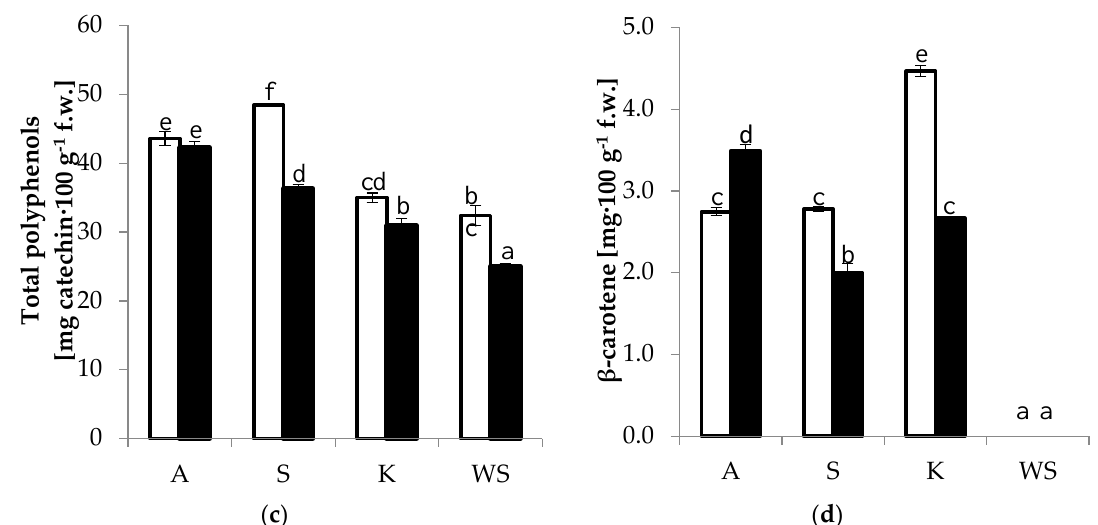
Figure 4. Antioxidant properties of carrot juices. ( a ) Antiradical activity relative to the ABTS; ( b ) Antiradical activity relative to the DPPH; ( c ) Total polyphenols; ( d ) β-carotene. White bars, CJ and black bars, BCJ. Various types: A, Askona F1; S, Samba F1; K, Kazan F1; WS, White Satin. Mean ± SE, the same letters set no differences at p < 0.05.